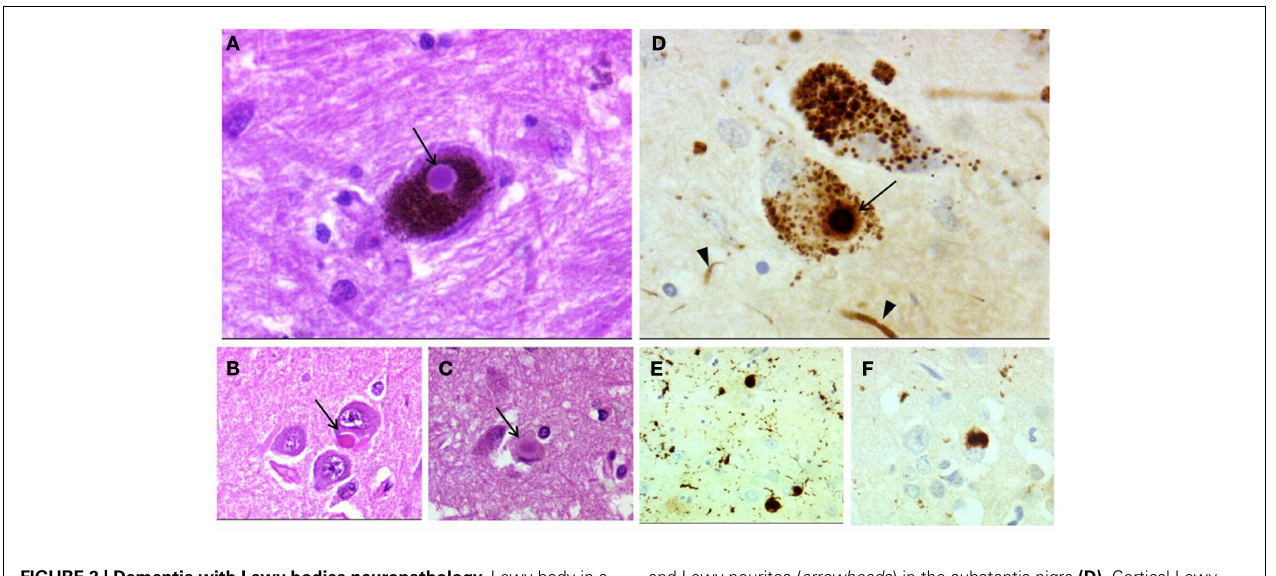
FIGURE 2 | Dementia with Lewy bodies neuropathology. Lewy body in a neuron of the substantia nigra (A) , in a pyramidal cell of CA1 area of the hippocampus (B) , and in cingulated cortex (C) ( arrows ). Lewy body ( arrow )